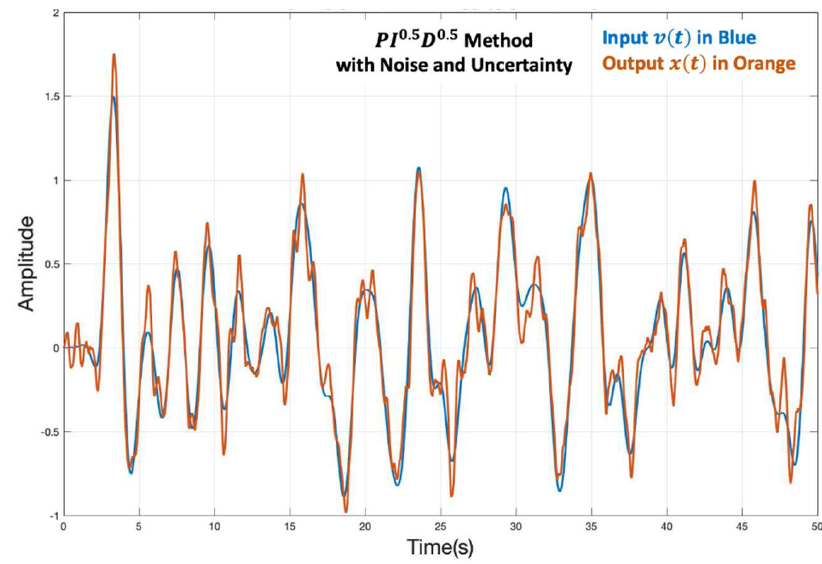
Figure 23. Impact of Noise and Uncertainty (Technique 4).